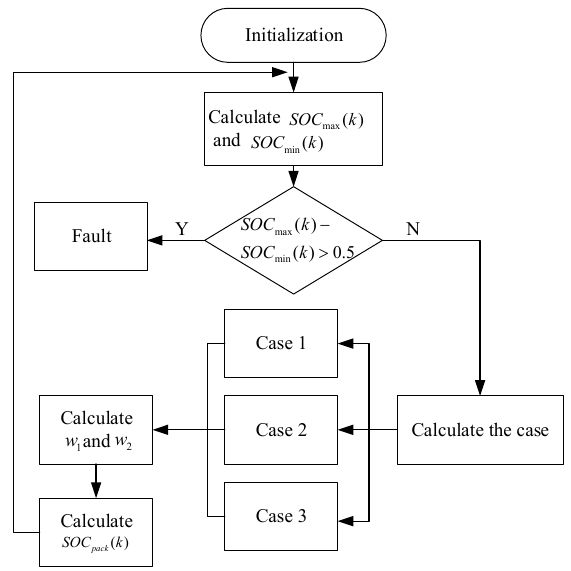
Figure 6. The calculation flowchart for the pack SOC estimation.